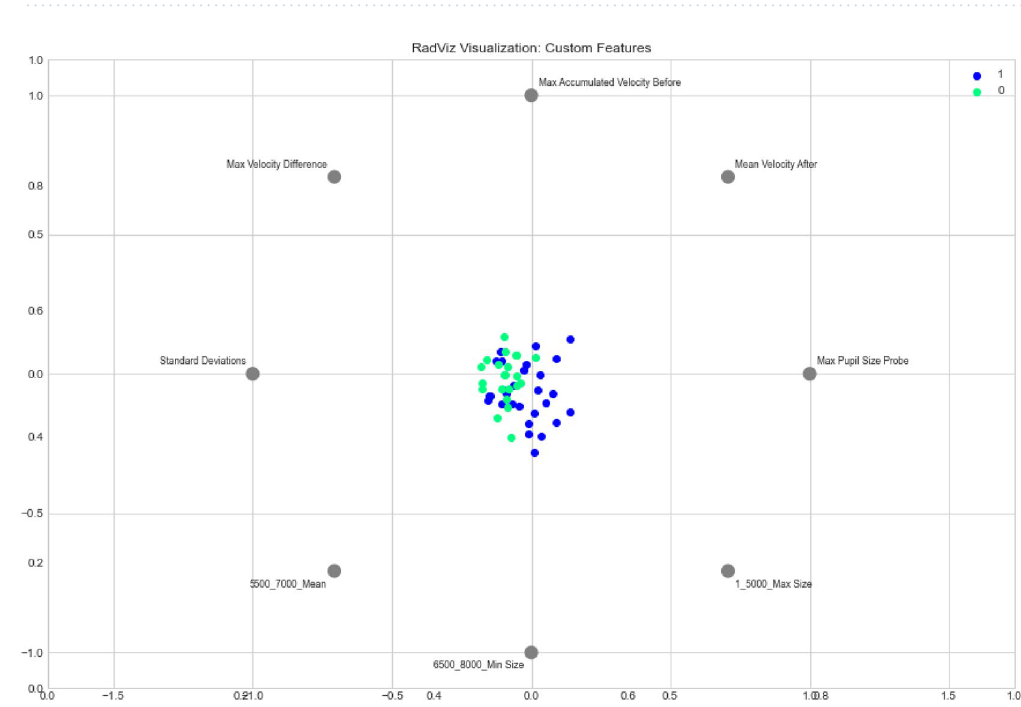
Figure 5. RadViz visualization of statistically significant custom